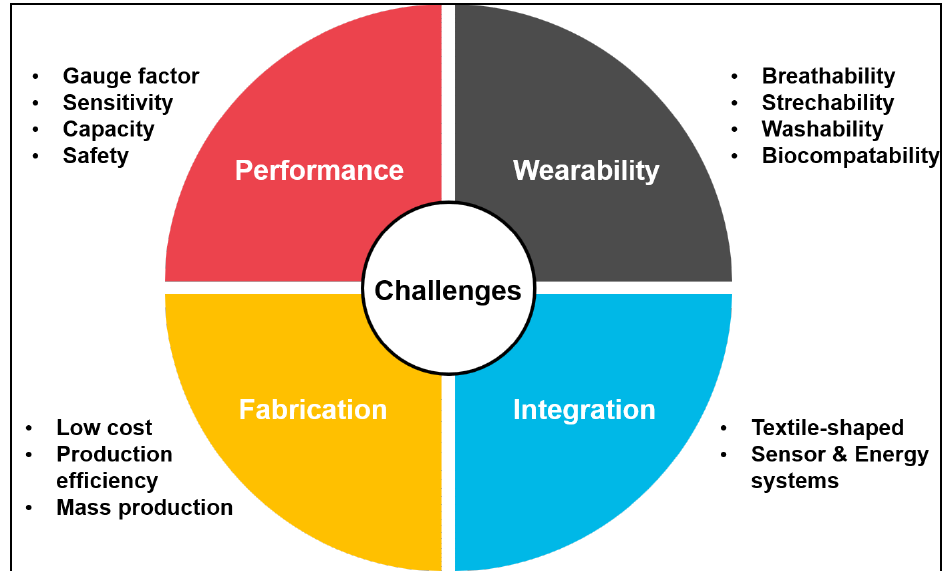
Figure 9. Challenges of fiber-based electronics toward wearable applications.